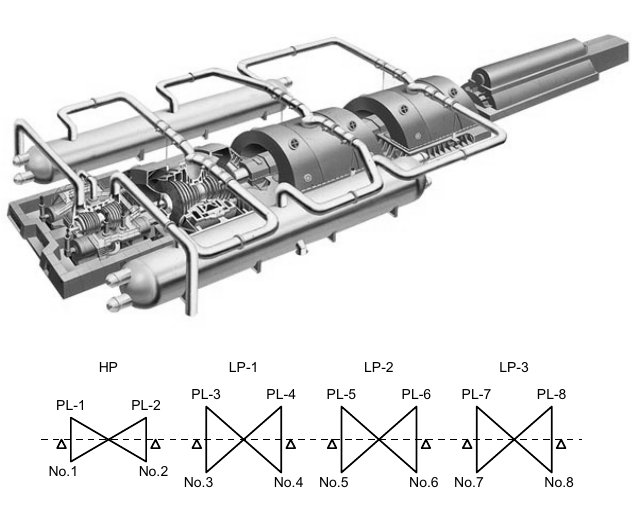
Fig. 2. Nuclear turbine